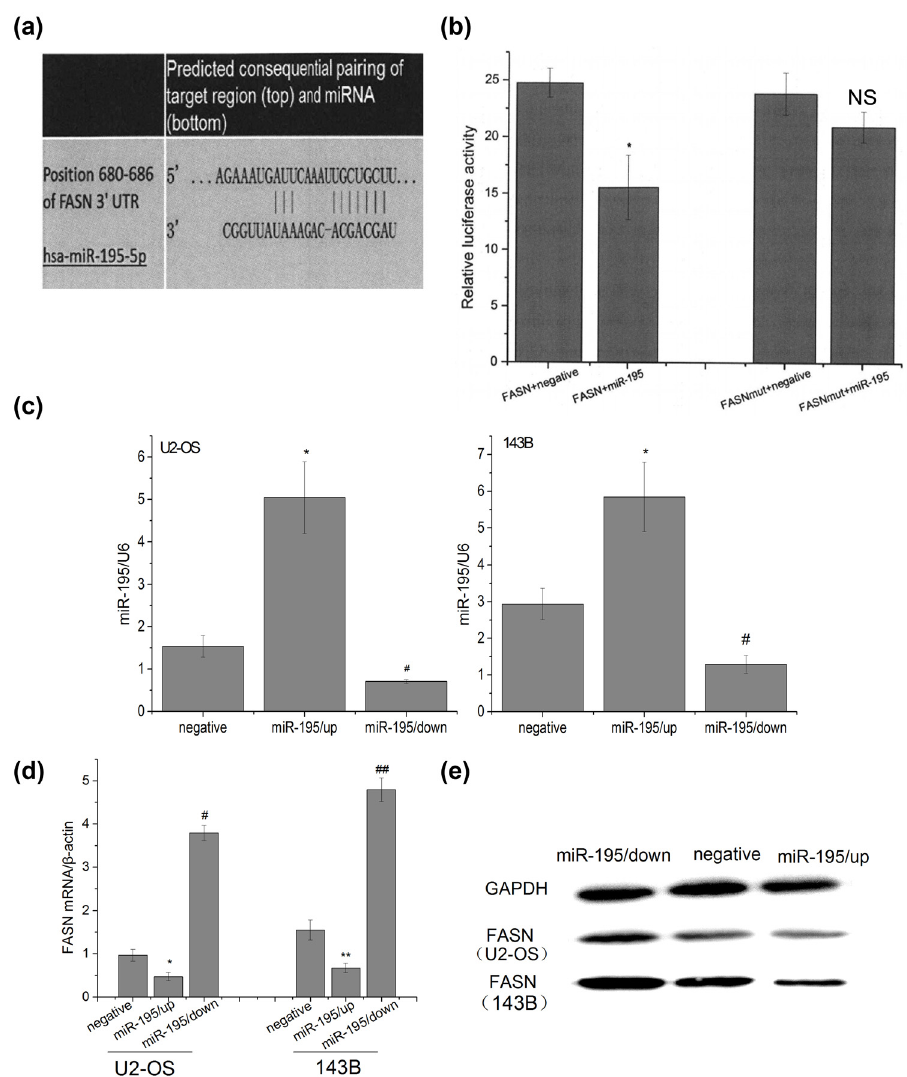
Figure 2: miR - 195 targeted and decreased the expression of FASN. ( a ) Target Scan Human 6.0 software predicted that there was a target site of miR - 195 on 680 – 686 bp of 3 ′ - UTR of FASN. ( b ) Luciferase activity assay showed the following: the luciferase activity in the group psi - FASN Vector + miR - 195 was signi fi cantly lower than that in the group FASN + negative controls ( n = 6; p < 0.001 ) , but there were no signi fi cant di ff erences between the group psi - FASN mutVector + miR - 195 and the group FASN mut + negative ( n = 6: # p = 0.083 ) , and the luciferase activity in the group psi - FASNmut Vector + miR - 195 was signi fi cantly higher than that in the group psi - FASN Vector + miR - 195 ( n = 6; ** p < 0.001 ) . The error bar represents the standard variation of the luciferase activity in the cells transfected with FASN ( or mutant FASN ) plasmids and treated with or without miR - 195. ( c ) The expression level of miR - 195 was signi fi cantly up/downregulated in U2 - OS and 143B cells transfected by miR - 195/up or miR - 195/down lentiviral vector ( n = 6 ) . The error bar represents the standard variation of the miR - 195 levels in the U2 - OS or 143B cells transfected with lentiviruses overexpressing or inhibiting miR - 195. ( d ) The FASN mRNA expression of osteosarcoma cells decreased signi fi cantly in the group miR - 195/up and signi fi cantly upregulated in the group miR - 195/down in vitro by RT - PCR analysis ( n = 6 ) . The error bar represents the standard variation of the FASN levels in the U2 - OS or 143B cells transfected with lentiviruses overexpressing or inhibiting miR - 195. ( e ) The FASN protein expression of osteosarcoma cells decreased signi fi cantly in the group miR - 195/up and signi fi cantly upregulated in the group miR - 195/down in vitro by western blot analysis ( n = 6 )